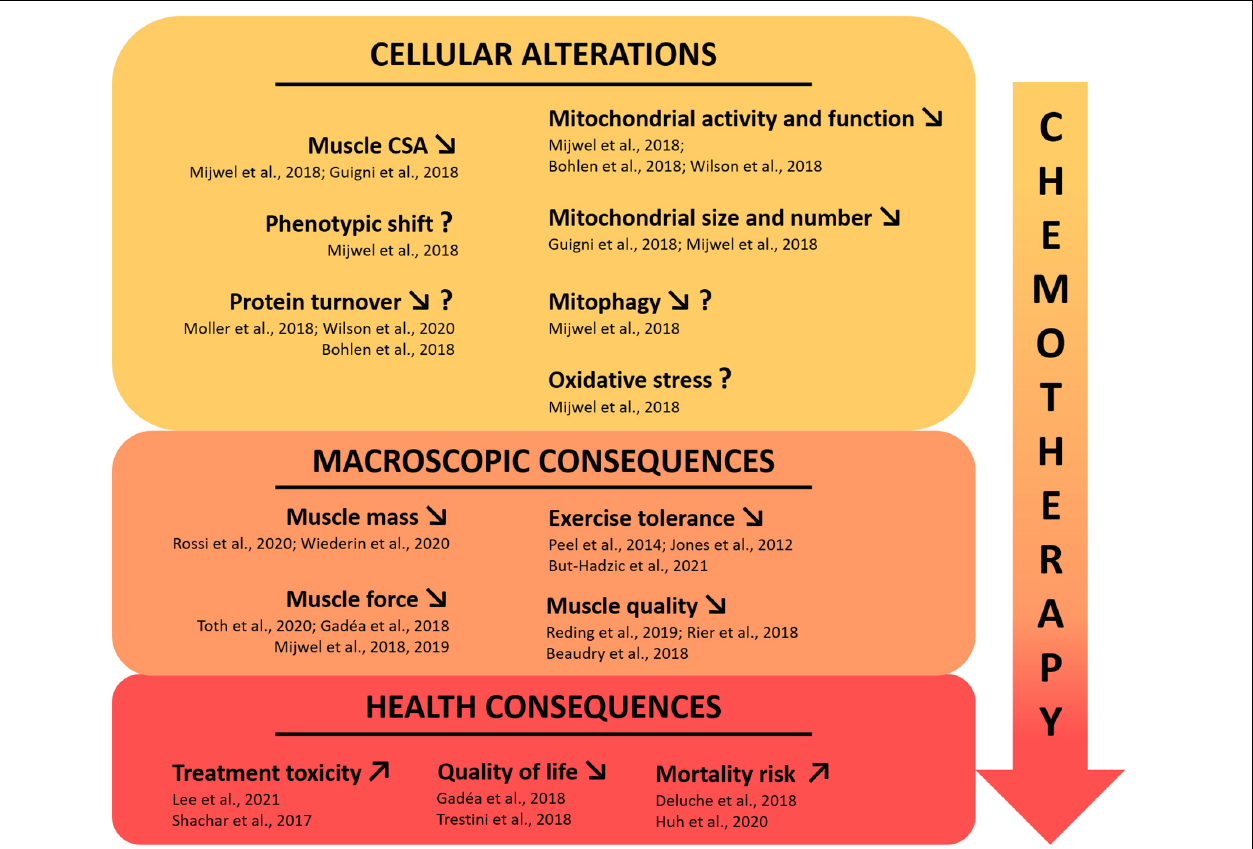
FIGURE 1 | Current state of knowledge on skeletal muscle deconditioning in breast cancer patients. The use of chemotherapeutic agents in clinical breast cancer treatment is directly affecting skeletal muscle tissue, leading to major muscle deconditioning. To date, few clinical studies investigated the underlying cellular mechanisms that may be responsible for the macroscopic changes highlighted in breast cancer patients, affecting muscle function and having severe health consequences. The question mark indicates inconsistent results or a mechanism that needs to be consolidated with more studies. CSA, cross sectional